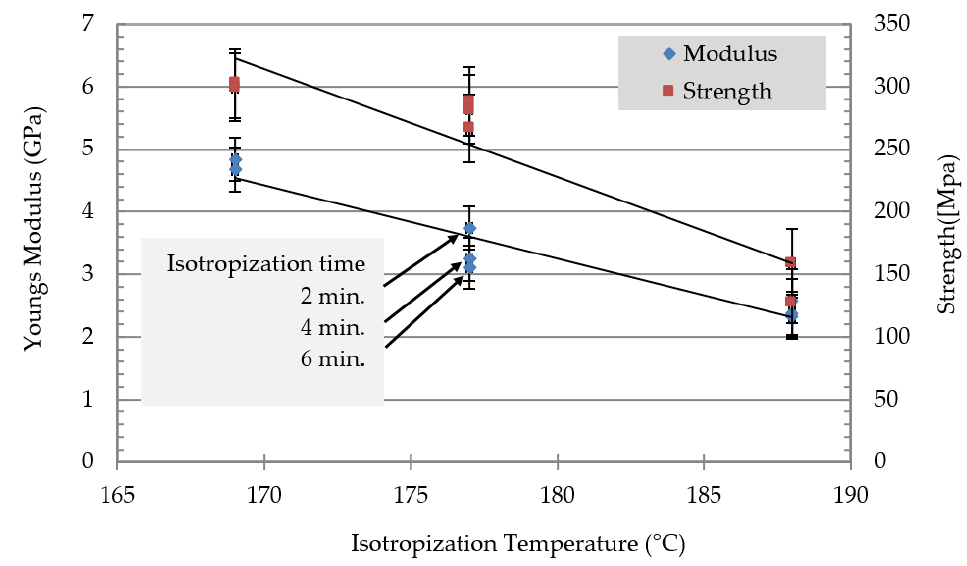
Figure 5. Isotropization of stretched MFC filament of 22 wt% PET.